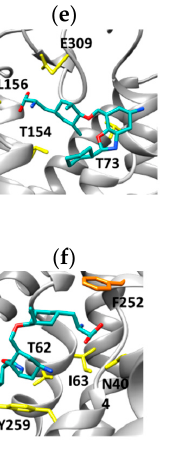
Outward Occluded